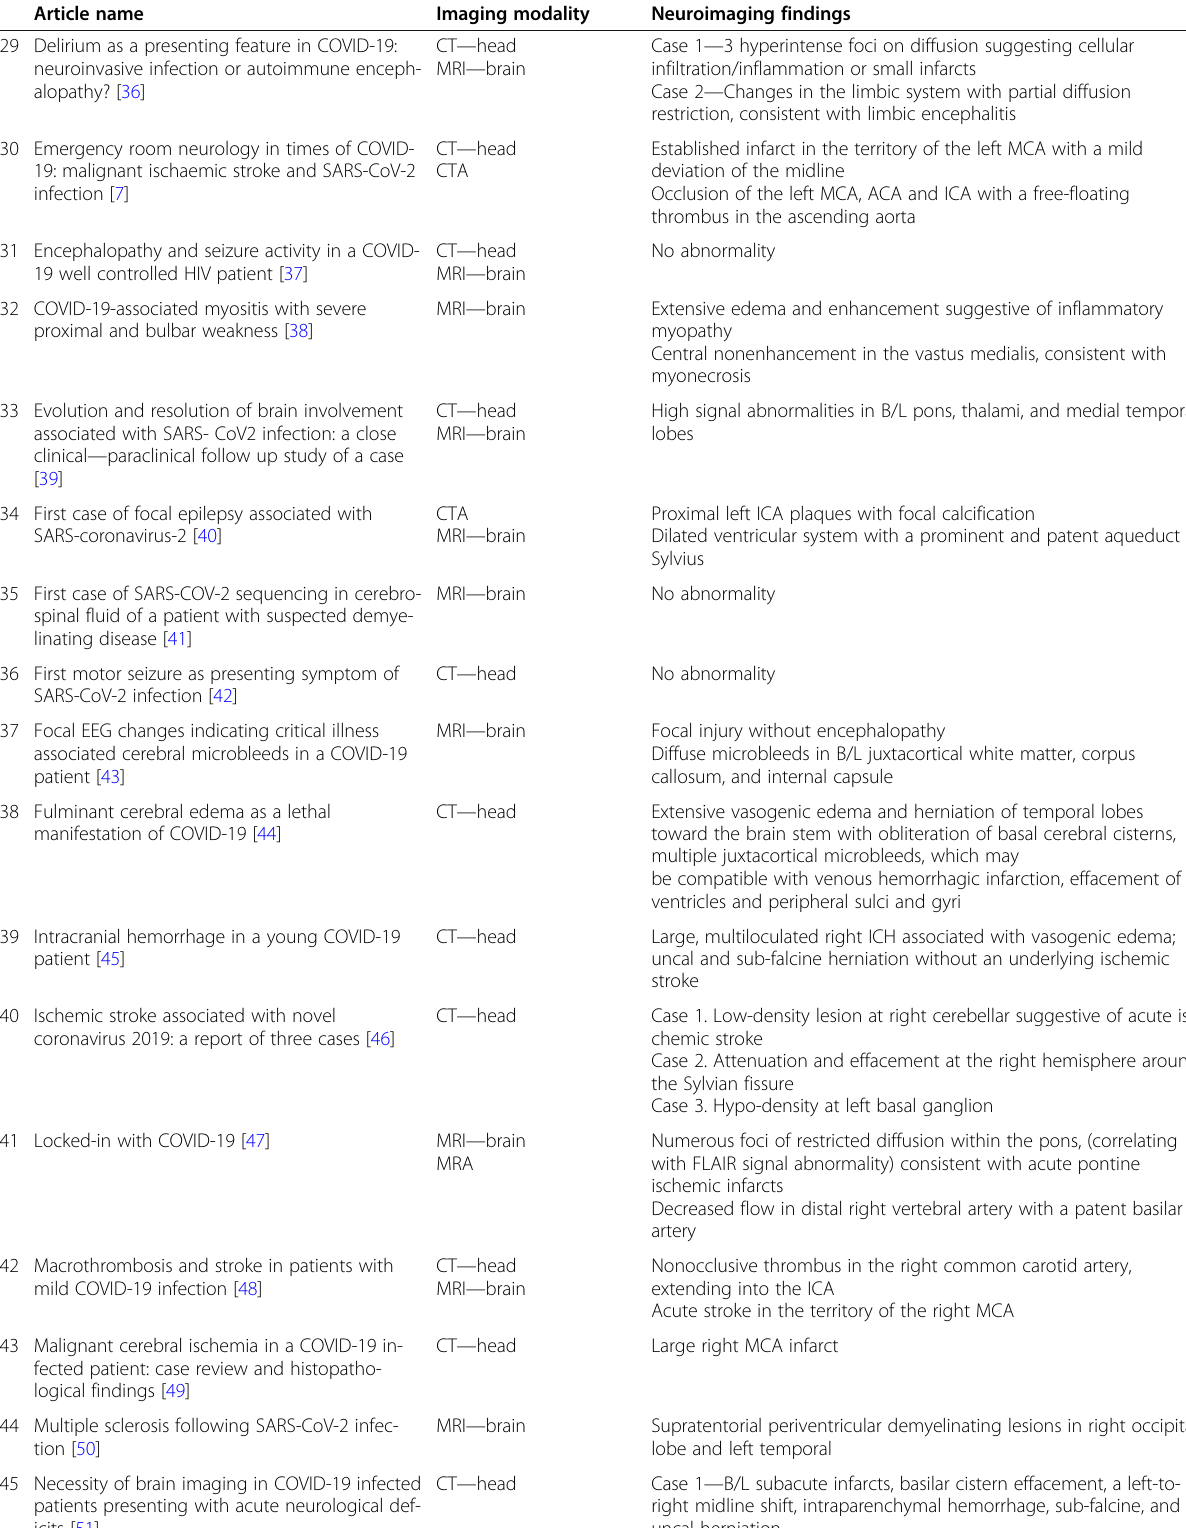
Table 1 Reported studies on COVID-19 patients with neurological manifestations with positive findings on major